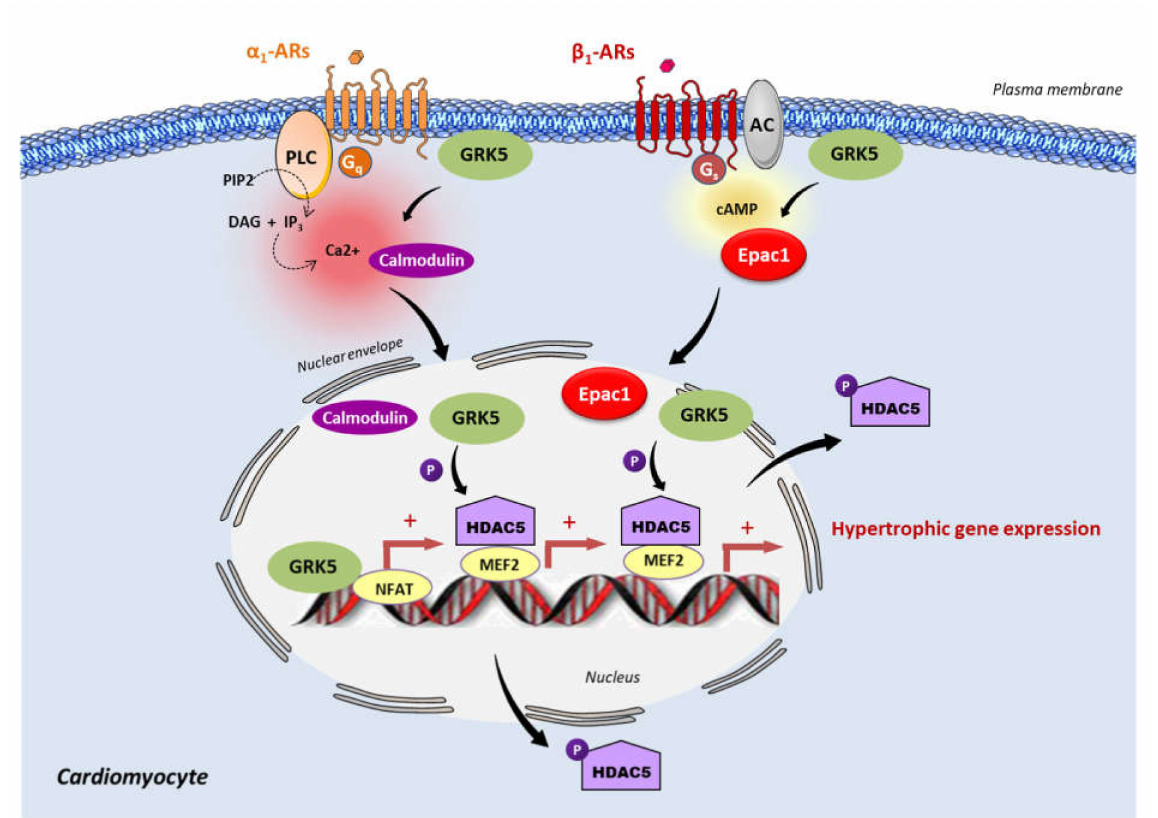
Figure 2. Epac1 and GRK5 non-canonical hypertrophic signaling. Activation of the G α q coupled receptor, α 1 -adrenergic receptor ( α 1 -AR), promotes the intracellular elevation of Ca 2+ through the phospholipase C (PLC) and the subsequent activation of calmodulin. GRK5 associates with Ca 2+ -calmodulin, leading to the translocation of GRK5 to the nucleus, wherein it promotes HDAC5 phosphorylation and subsequent myocyte enhancer factor 2 (MEF2) activation. During the chronic stimulation of β 1 -adrenergic receptor ( β 1-AR), Epac1 interacts with GRK5 and the Epac1-GRK5 molecular complex is exported to the nucleus of cardiomyocytes. There, GRK5 phosphorylates HDAC5, leading to its nuclear export, and thereby derepressing MEF2 transcriptional activity. GRK5 also acts as a coactivator of the nuclear factor of activated T cells (NFAT). MEF2 and NFAT are crucial transcription factors that promote cardiac